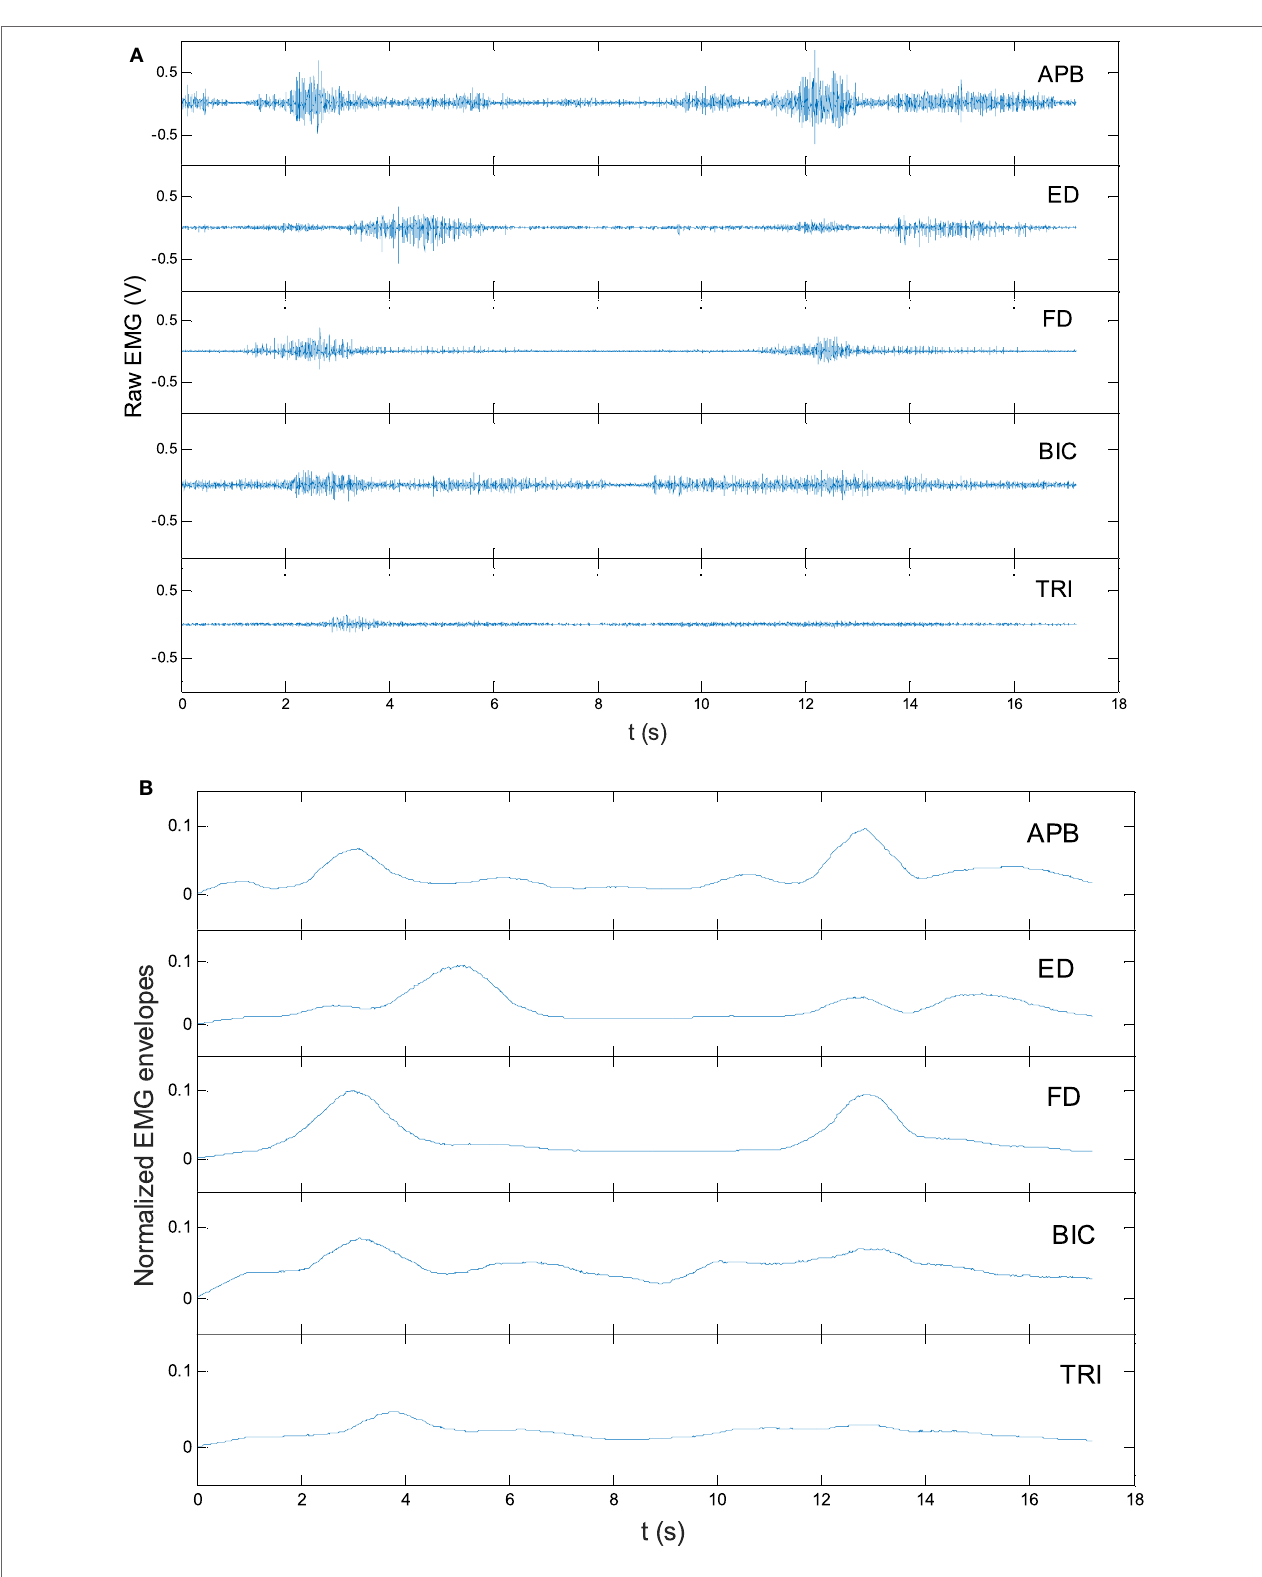
FiGUrE 3 | The representative raw electromyography (EMG) trials in a lateral arm reaching–grasping task (a) and the EMG envelopes after rectification and normalization (B)